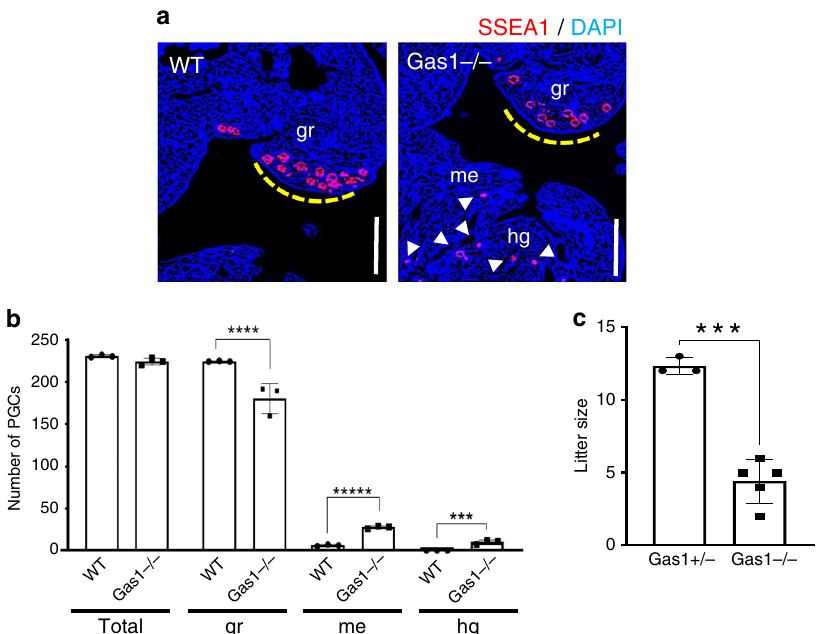
Fig. 10 Gas1-de fi cient mice show disrupted PGC migration and sub-fertility. a A representative image of immuno fl uorescence staining of E10.5 WT and Gas1 KO embryos ( n = 3) using anti-SSEA1 antibody demonstrates the presence of ectopic PGCs (arrows) in the mesentery (me) and hindgut (hg) in Gas1 KO. Dotted line indicates the genital ridges (gr) where the PGCs should have migrated at this stage of development. Scale bar, 500 µ m. b Total number of PGCs counted from every other sections of the entire embryo at E10.5 was combined per embryo from each genotype. The numbers of PGCs populated in the genital ridge, mesentery and hindgut are compared between WT and Gas1 KO. Error bars represent SD from three independent embryos after unpaired t -test. **** P = 0.000521 (gr), **** P = 0.000033 (me), **** P = 0.002814 (hg). c Litter size is shown as the number of pups per litter for each female caged with a WT male for 9 months. Unpaired t -test indicates a signi fi cant difference (*** P = 0.0002) in the litter size by Gas1 − / − mice ( n = 5) compared with Gas1 + / − ( n = 3), which were phenotypically normal. Error bars represent SD. Source data are provided as a Source Data fi